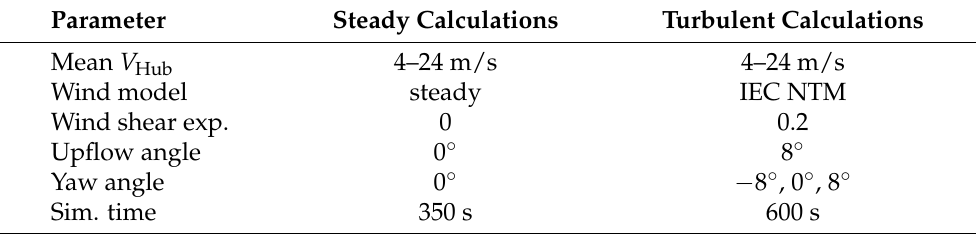
Table 4. Main Parameters of the Simulations used for Controller Verification.